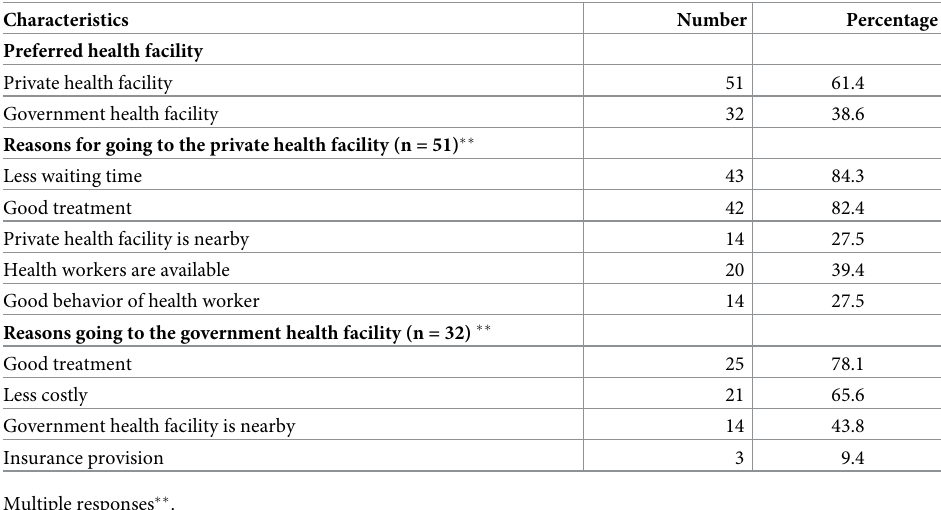
Table 3. Distribution of respondents by preferred type of health